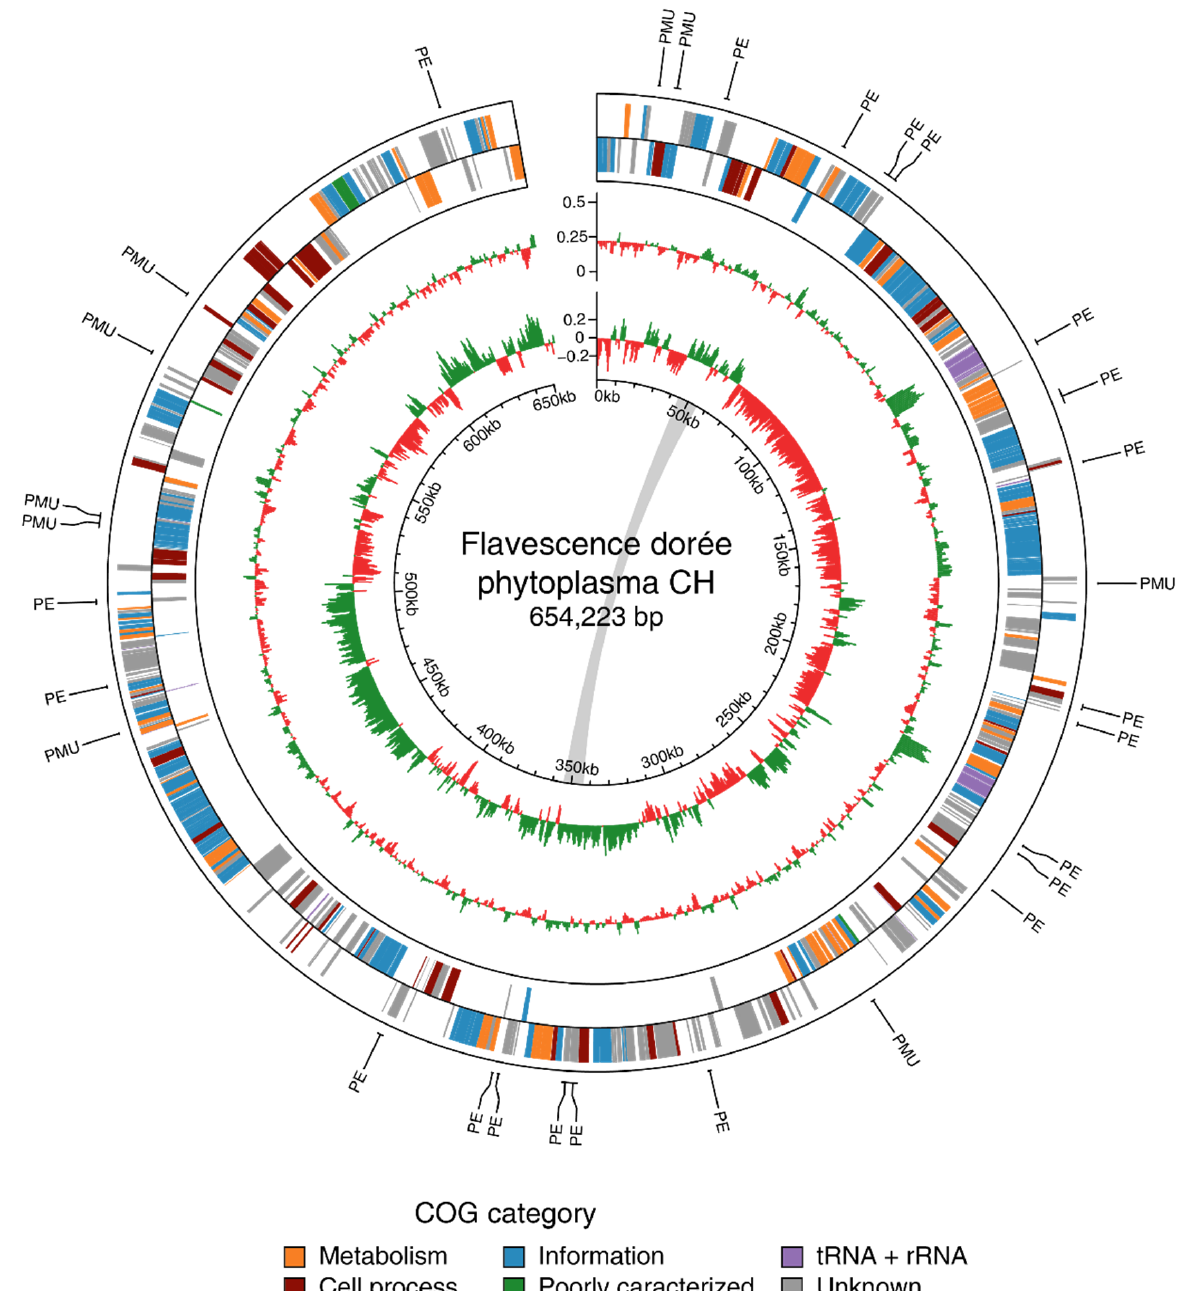
Figure 2. Genome map of the circular chromosome of FDp strain CH. Rings from outside in: (1 and